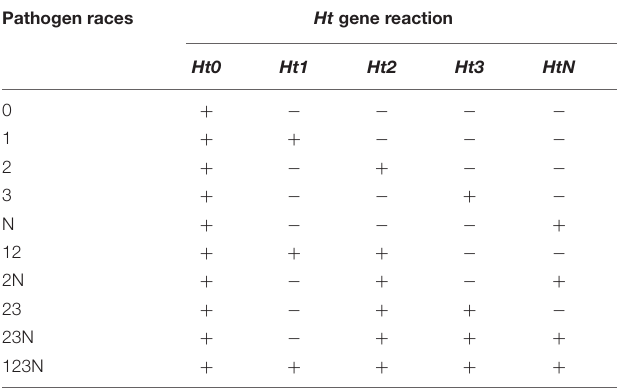
TABLE 1 | Gene-by-gene interaction between the pathogen and host plant (Welz, 1998). Pathogen